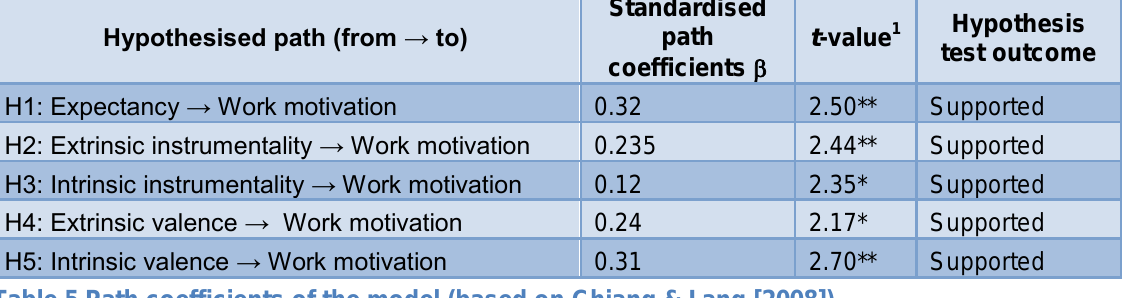
Table 5 Path coefficients of the model (based on Chiang & Jang